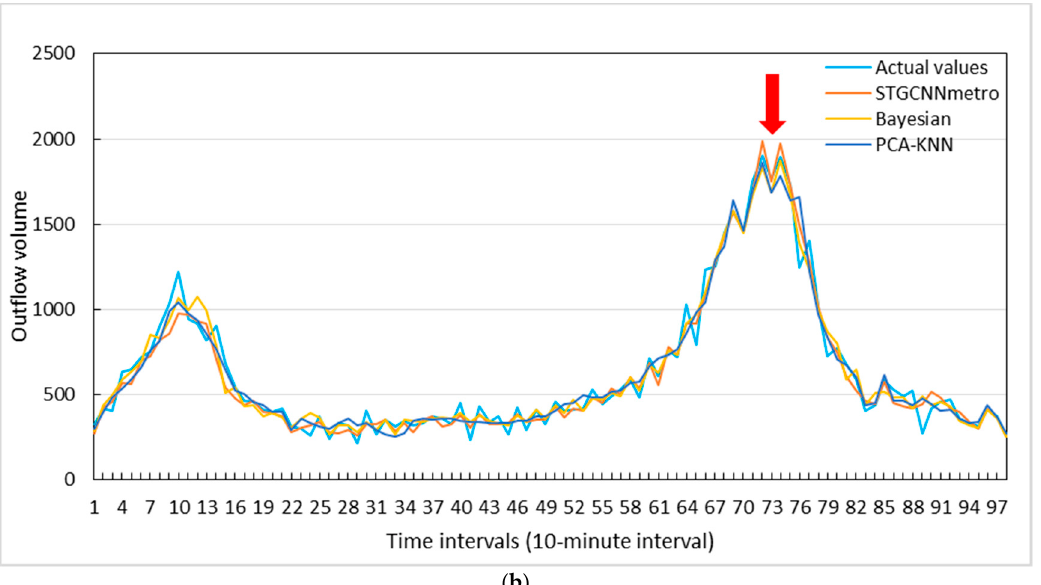
Figure 10. A comparison of the predicted and actual values of outflow volume between 6:40 a.m. and 11:00 p.m. for the Shenzhuang metro station on ( a ) a non-working day and ( b ) a working day.